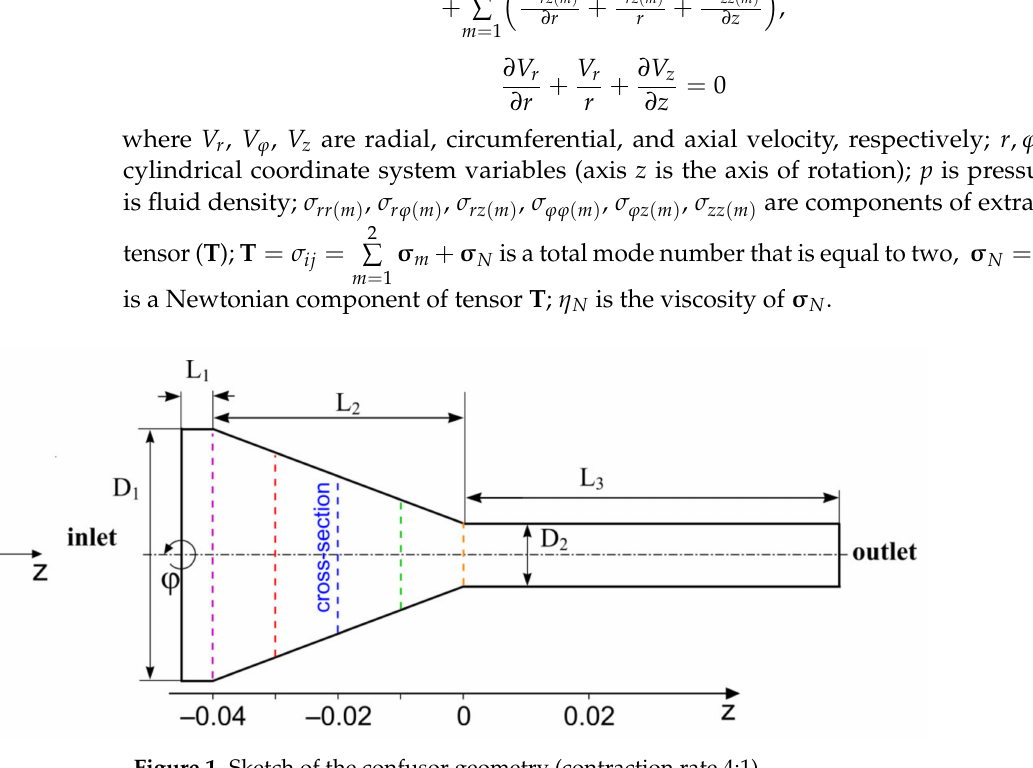
Figure 1. Sketch of the confusor geometry (contraction rate